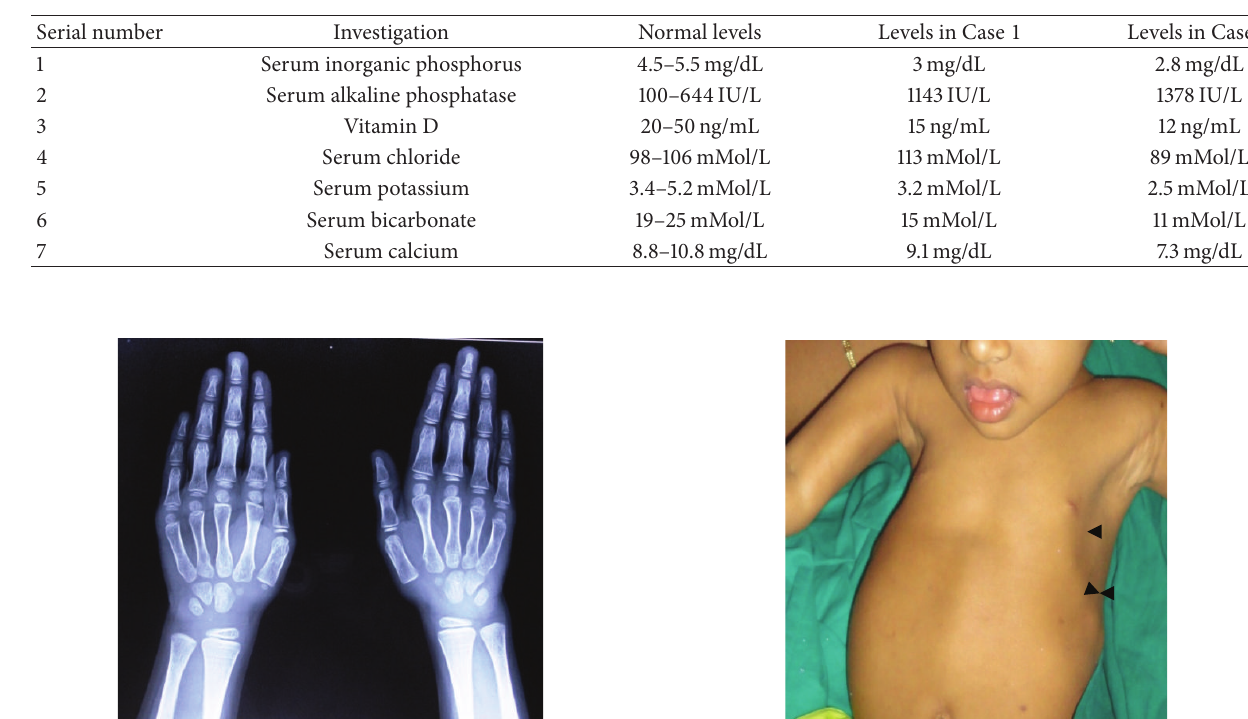
Table 1: Depicting the laboratory investigations of both the siblings.